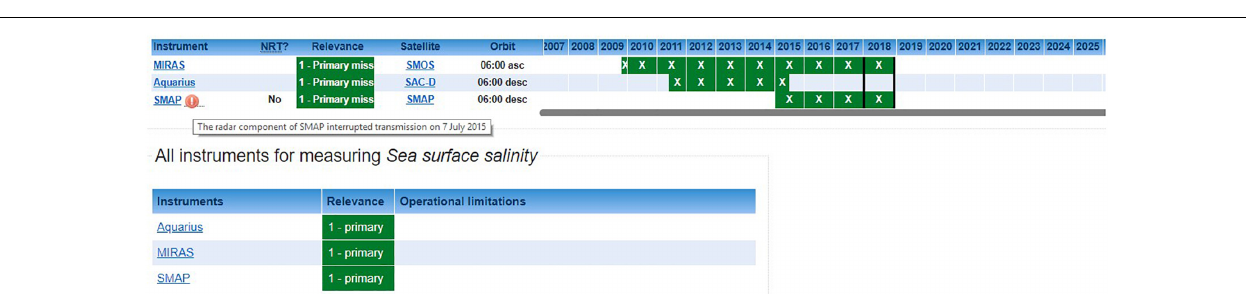
FIGURE 7 | OSCAR/Space screen shot showing gap analysis for sea surface